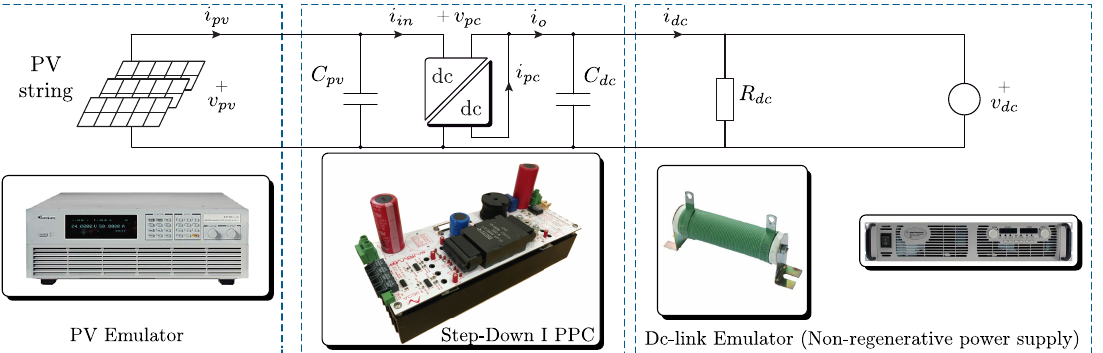
Figure 8. Experimental test-bench of the step-down PPC connected at dc-link side, using a full-bridge topology for string inverter